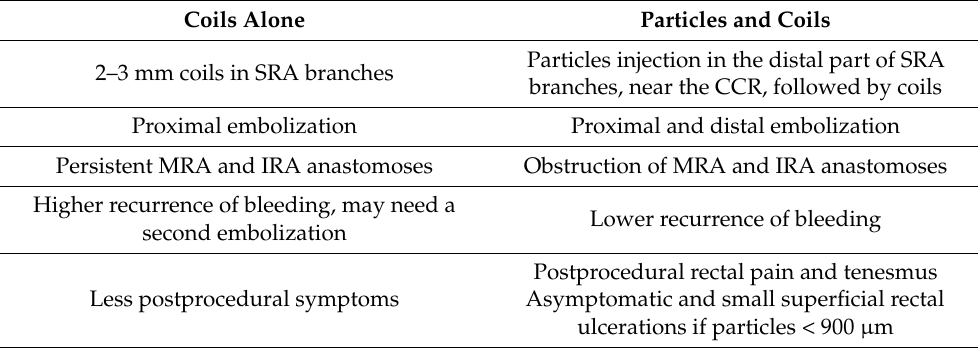
Table 4. Comparison between coil embolization vs. particles added to coil